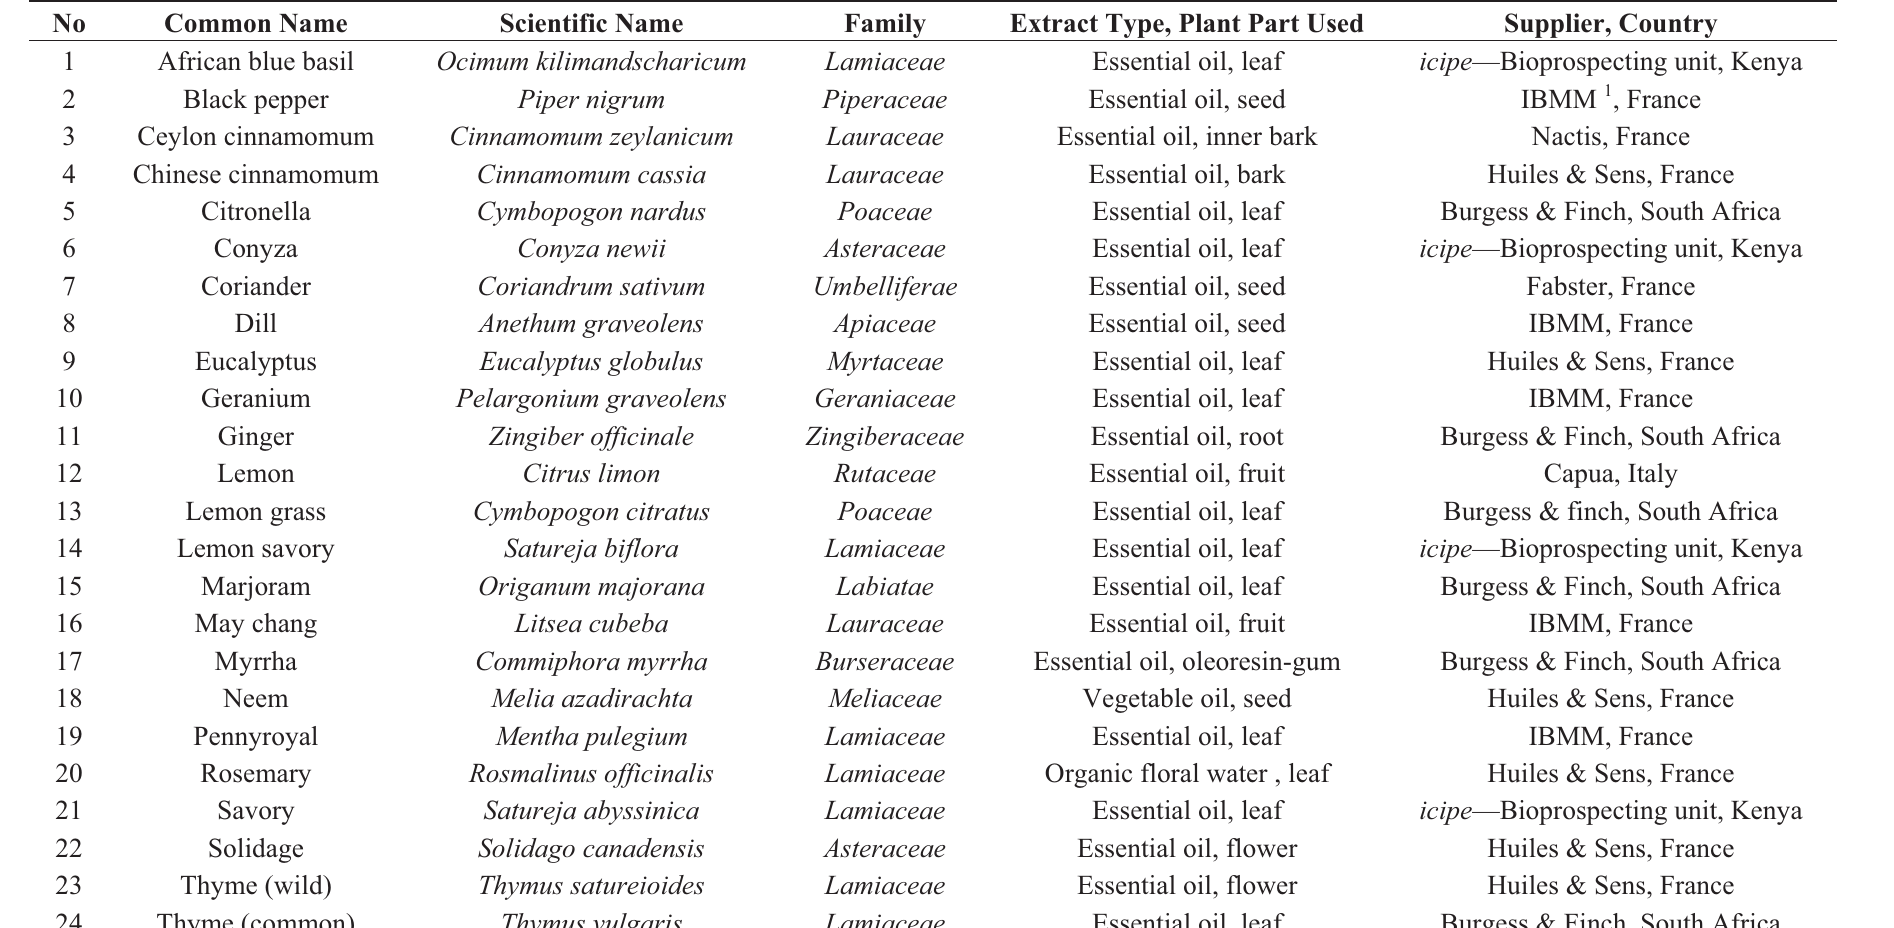
Table 1. Names and sources of the plant extracts used for the repellency